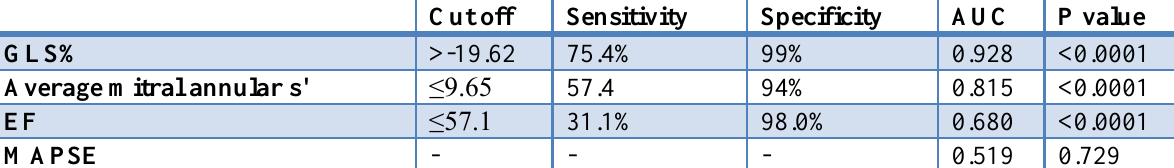
Figure 1: Relationship between EF % versus GLS in patients according to severity of AR. Table 5: Predictive characteristics of echocardiographic variables for the detection of left ventricular systolic dysfunction in asymptomatic patients with chronic aortic regurgitation